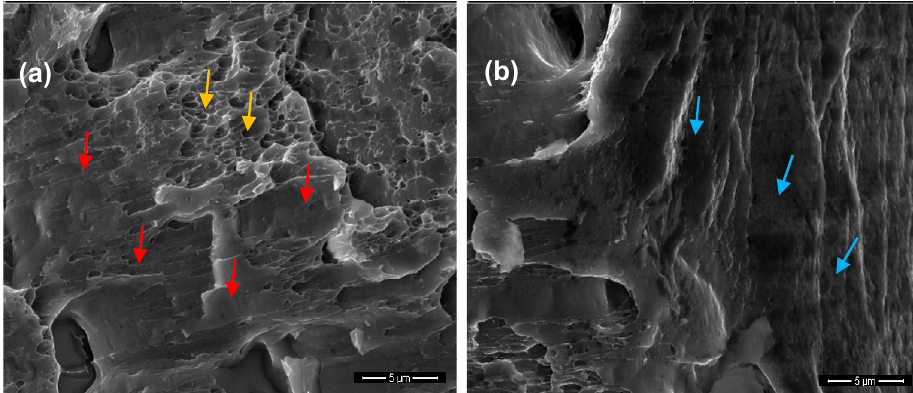
Figure 5. SEM analysis of brittle zones on the outer surface of the fractured surface of T6 treated 6082 aluminum alloy, after SSRT testing in ( a ) pH = 3 and ( b ) pH = 10.